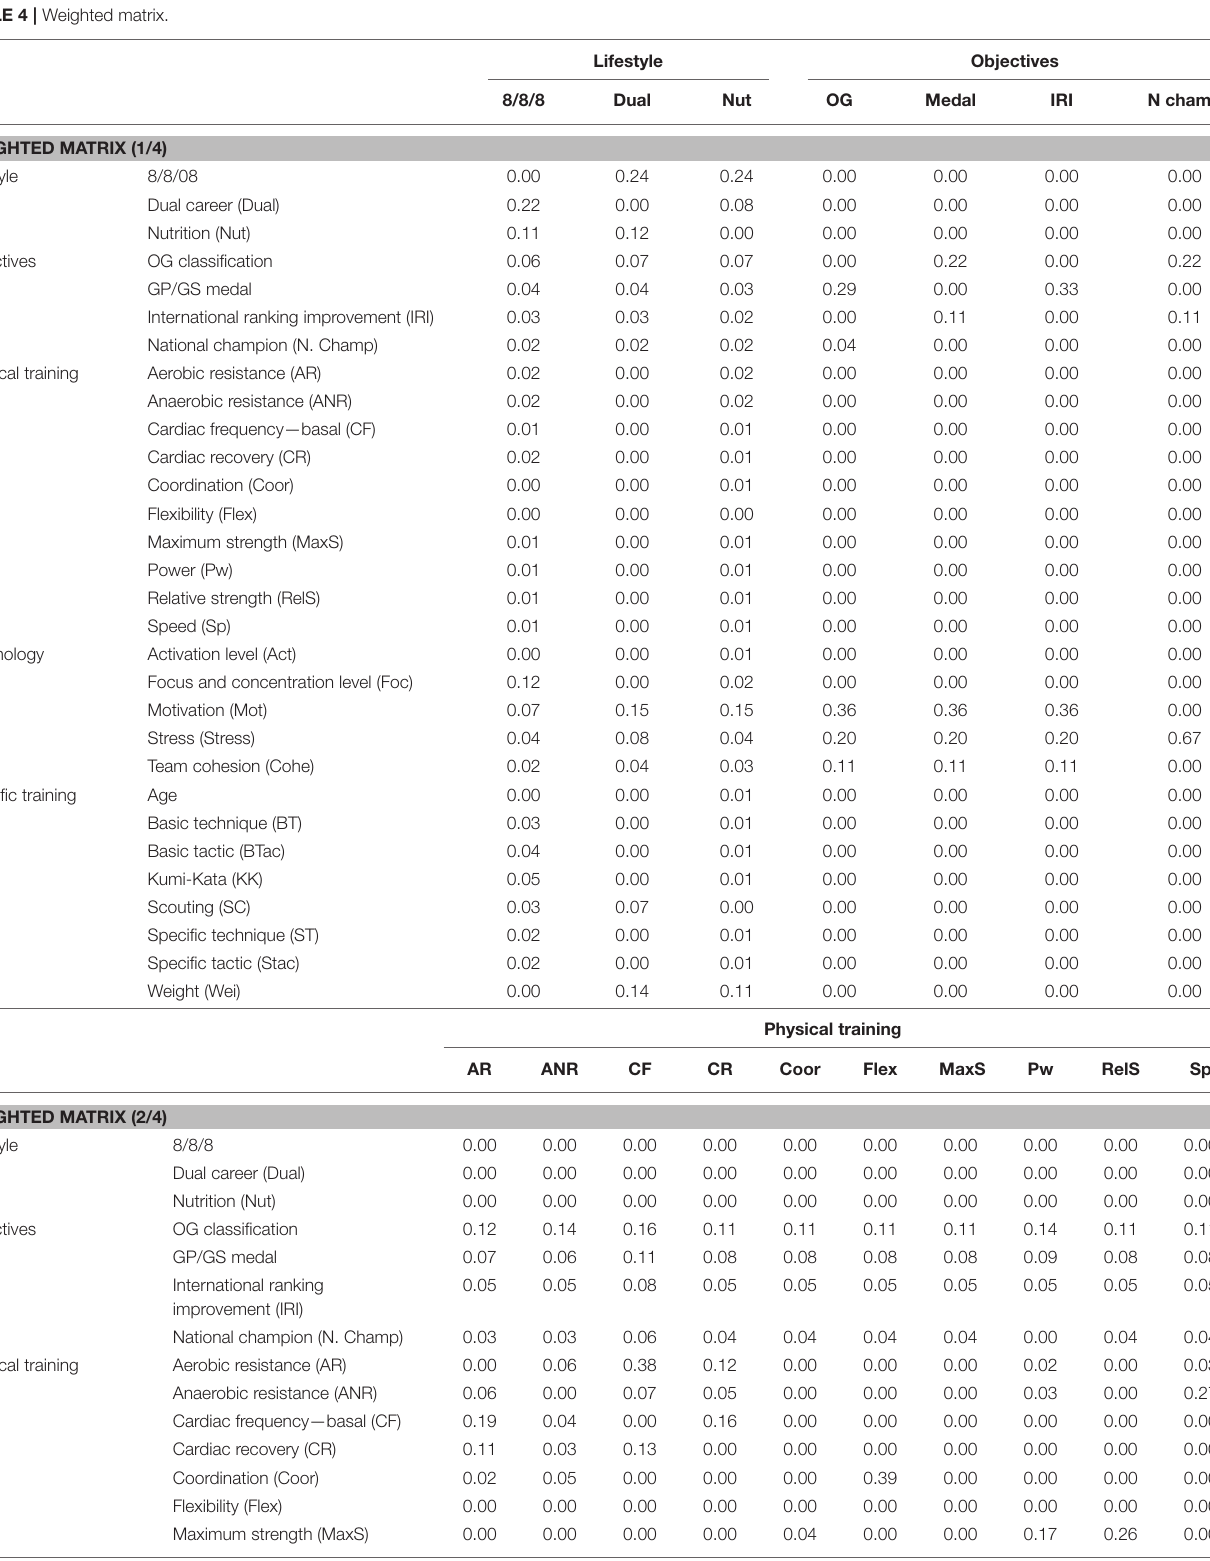
TABLE 4 | Weighted matrix.